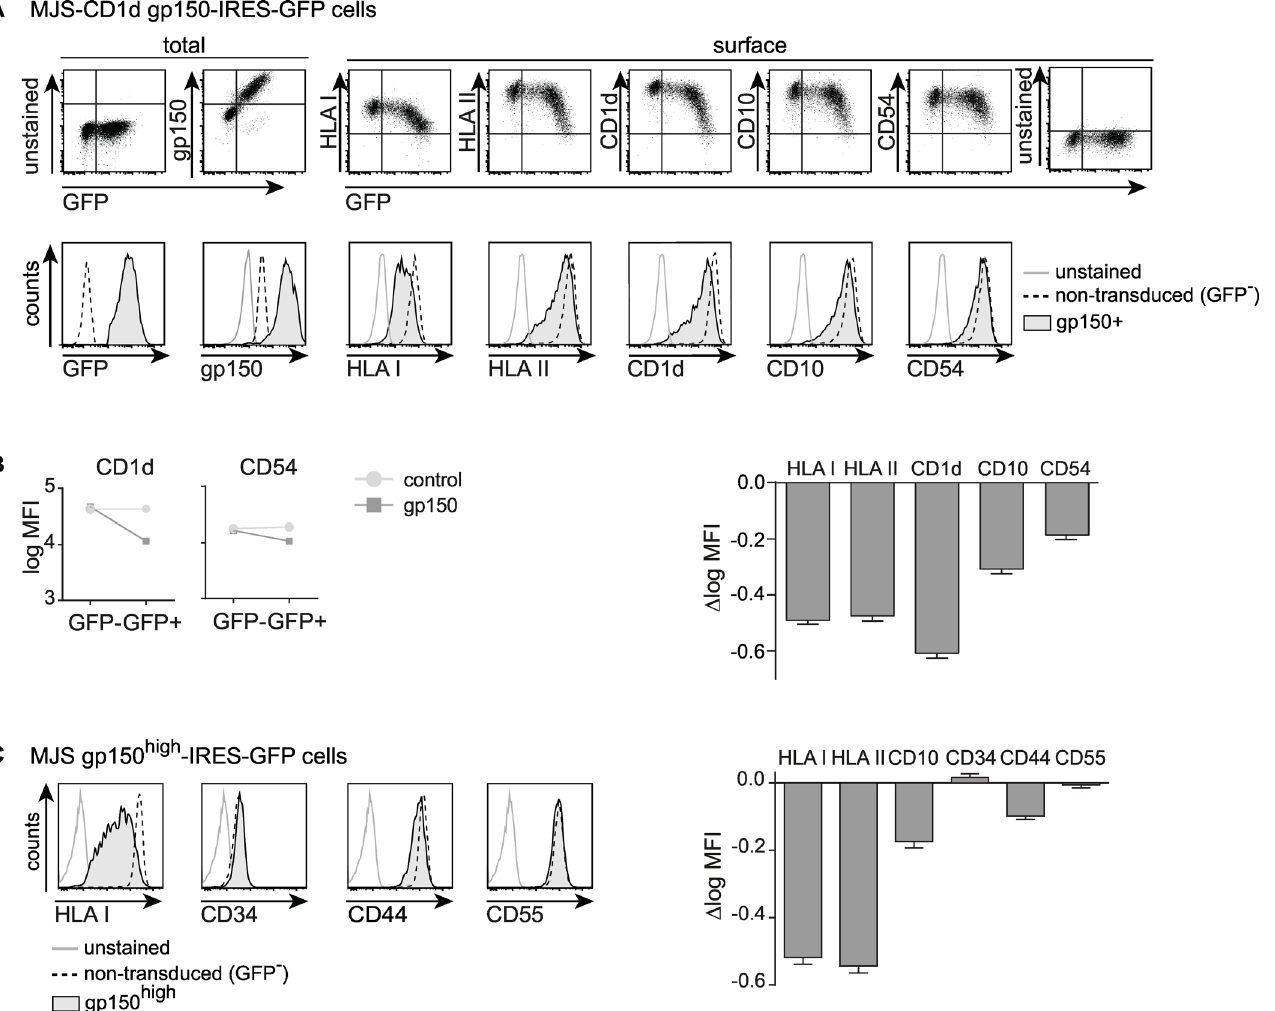
Fig 2. EBV gp150 is broadly acting, but displays a degree of specificity for antigen-presenting molecules. Flow cytometric analyses of MJS-CD1d cells (adherent fraction) three days post transduction with gp150-IRES-GFP lentiviruses. A) Total EBV gp150 levels were determined by intracellular staining of permeabilized cells. Surface levels of HLA I, II, CD1d, CD10, and CD54 were determined using Ab staining on non-permeabilized cells. B) Surface levels of CD1d and CD54 are depicted as log MFI values with 95% confidence intervals, for GFP + versus GFP - MJS-CD1d cells transduced with gp150 or a GFP control. The slopes of the connecting lines reflect the declines in fluorescence ( Δ log MFI) and, thus, the downregulation of HLA I, II, CD1d, CD10, and CD54 induced by gp150 (for the GFP control, the Δ log MFI did not significantly differ from 0). C) Cell surface levels of HLA I, II, CD10, CD34, CD44, and CD54 were determined using surface Ab staining. EBV gp150-induced downregulation of these molecules was calculated as in B) and represented as Δ log MFI.